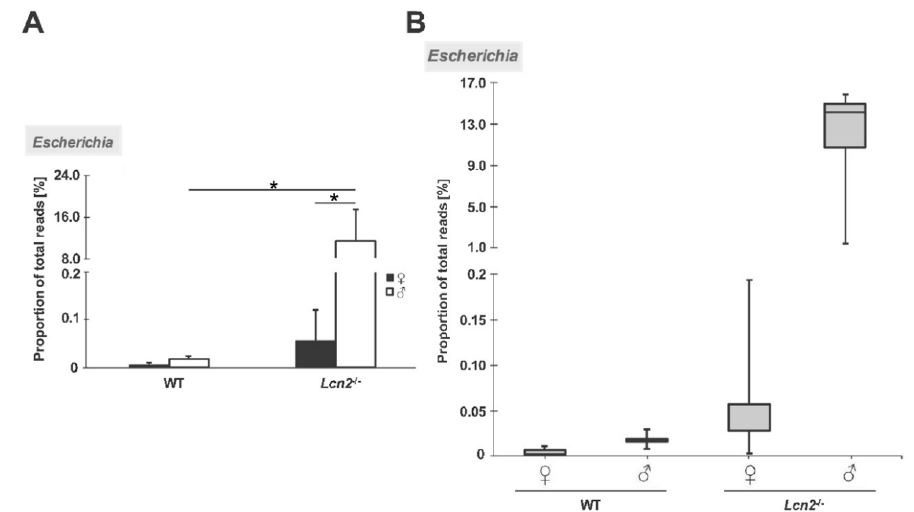
Figure 7. Frequency distribution of the data using the example of the genus Escherichia . ( A ) Percentage of total reads [%] in the different genders and genotypes ( Lcn2 -/- (n = 7 or 5) and wild type mice (n = 7 or 3)). ( B ) The relative abundance is plotted as a percentage of the total reads [%]; 50% of the mean data lie within the boxes. In the box plot, the whiskers range from the quartiles to the minimum or maximum including outliers is shown. *: p <